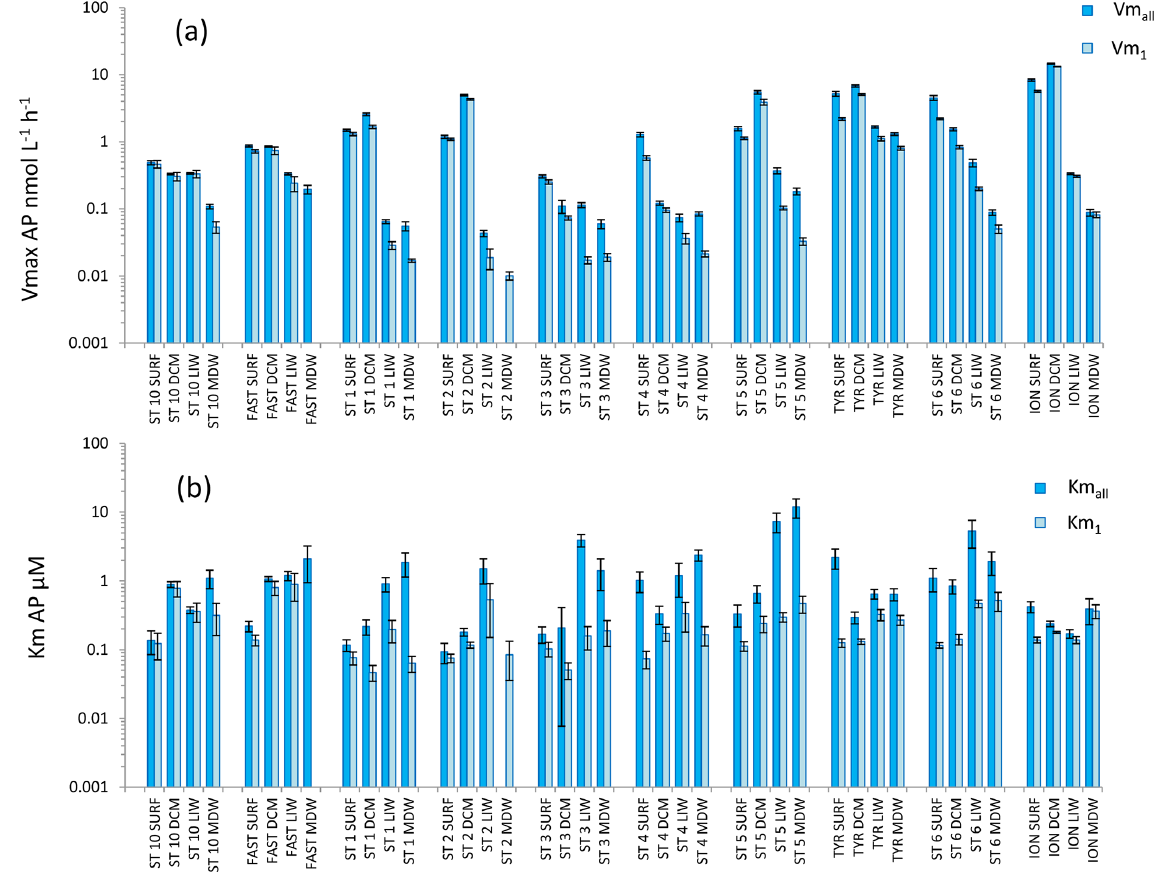
Figure 7. Distribution of kinetic parameters Vm (a) and Km (b) for alkaline phosphatase (AP) calculated from model 1 (Vm 1 , Km 1 ) and the global model (Vm all , Km all ). Error bars are the standard errors derived from the nonlinear regressions. Table 4. Range of different specific activities calculated using Vm 1 and specific to either (i) abundance of total heterotrophic prokaryotes (cell-specific – cs – activities) or (ii) heterotrophic bacterial production (per BP LAP, per BP β GLU, per BP AP). DVF is the “depth variation factor”, calculated for each station as the mean value in epipelagic water (SURF and DCM data) divided by the mean in deep waters (LIW and MDW). The distribution of cs-Vm 1 and cs-Vm all for AP and LAP is also presented in Fig. 8. nd: not determined. Enzyme